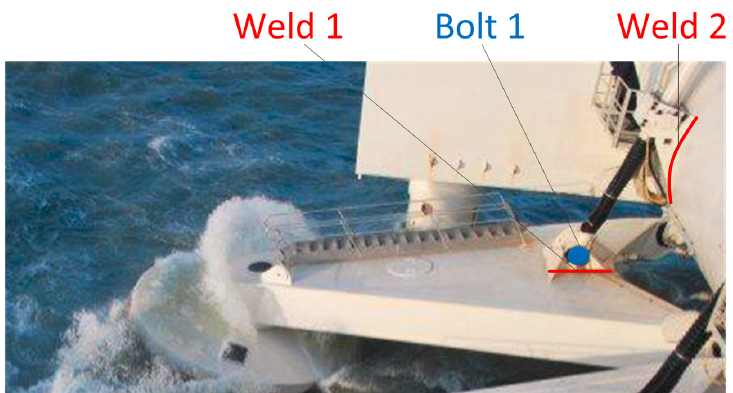
Figure 7. Position of the two welded details as well as the bolted connection between the arm and the power take off (PTO) of the Wavestar